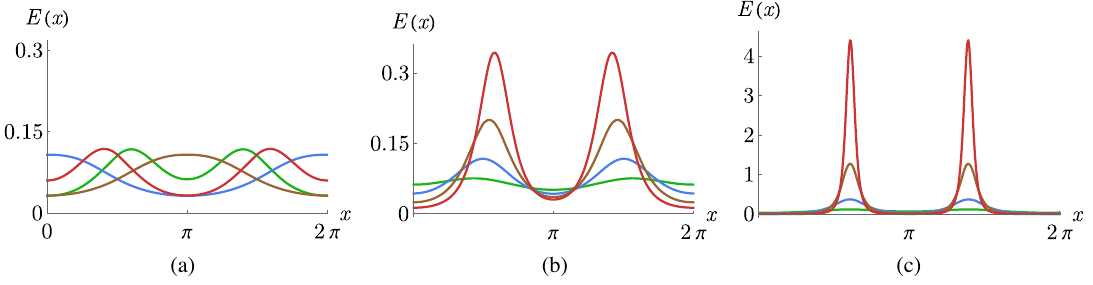
FIG. 5. The evolution of energy density profile in different phases. In the plot, we choose the system size L ¼ 2 π and the central charge c ¼ 1 . Different colors mean different times. The green, blue, brown, and red curves correspond to t ¼ T , 2 T , 3 T , 4 T , respectively. (a) T 0 ¼ 0 . 5 L and T 1 ¼ 0 . 1 L , which is in the nonheating phase. The energy density oscillates only (b) T 0 ¼ 0 . 9 L , and T 1 is tuned to make the system right at the phase boundary. The position of the peaks in the plot are not given by γ , because we are not at the late-time regime. One can check that, as we increase n , the peaks move toward log γ . (c) T 0 ¼ 0 . 9 L and T 1 ¼ 0 . 1 L , which is in the heating phase. We can clearly see the formation and growth of two peaks.